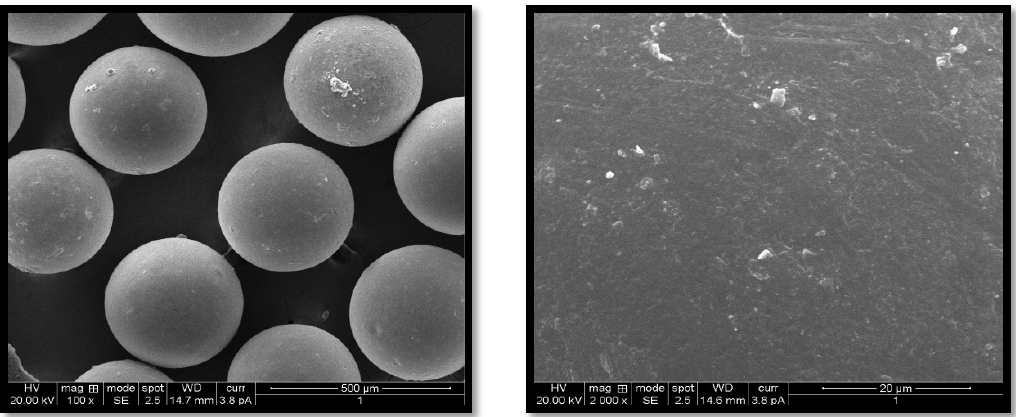
Figure 5. SEM of the optimized formulation at various